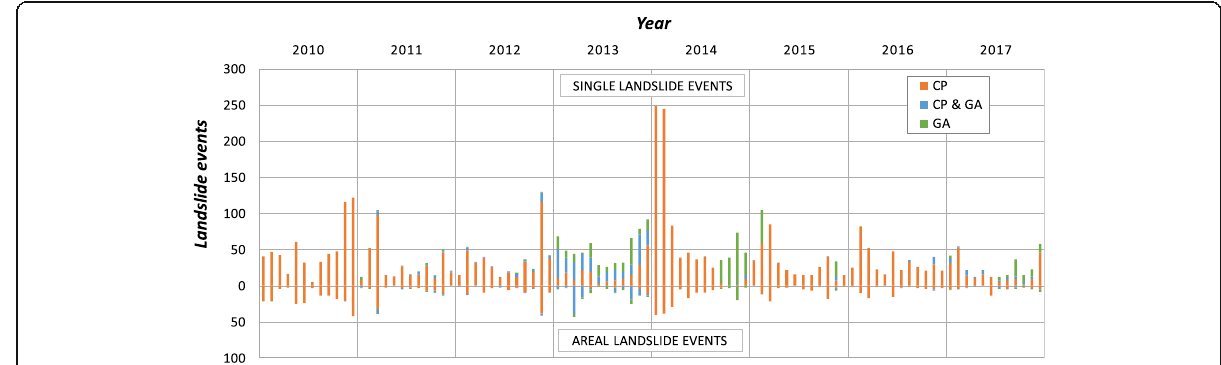
Fig. 3 Number of monthly single and areal landslide events, differentiated by source of data. [Legend: CP=Civil Protection press review; GA = Google Alert]